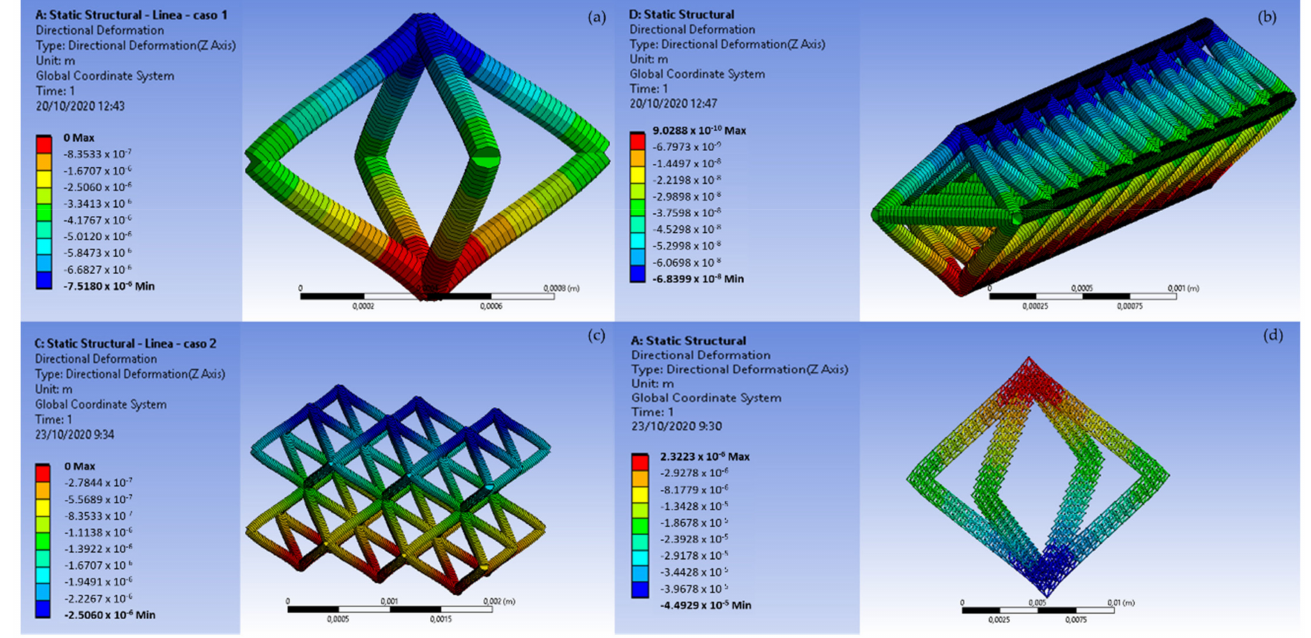
Figure 10. Directional deformation ( Z axis), of the four designs ( a – d